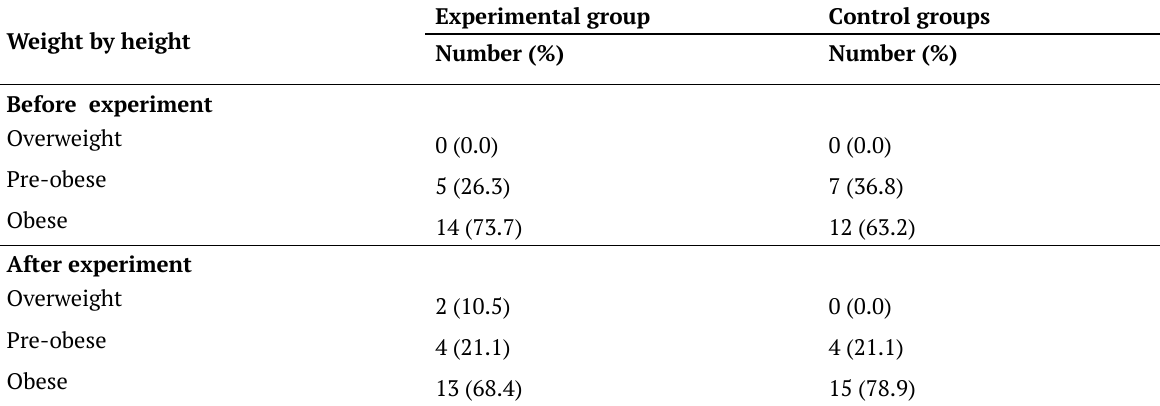
Table 3. Bodyweight by height among experimental and control